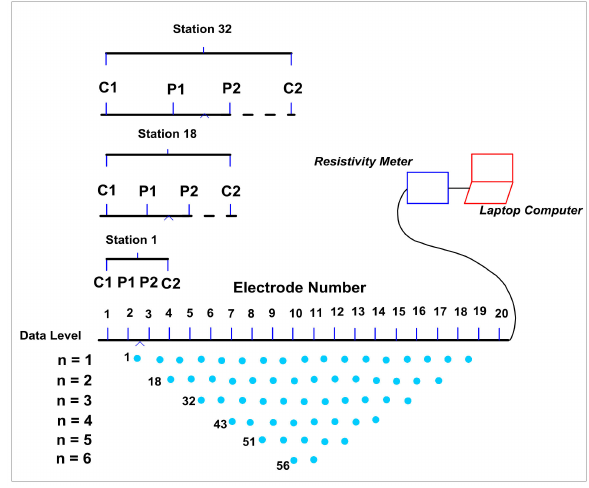
Figure 4. Principle for building up a pseudo-section using pole-dipole array (modified after